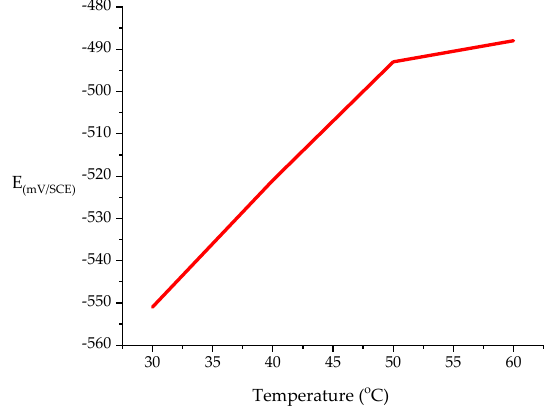
Figure 5. OCP ( open circuit potential ) as a function of temperature for MS in 1.0 N H 2 SO 4 with 0.5 mM corrosion inhi bitor.